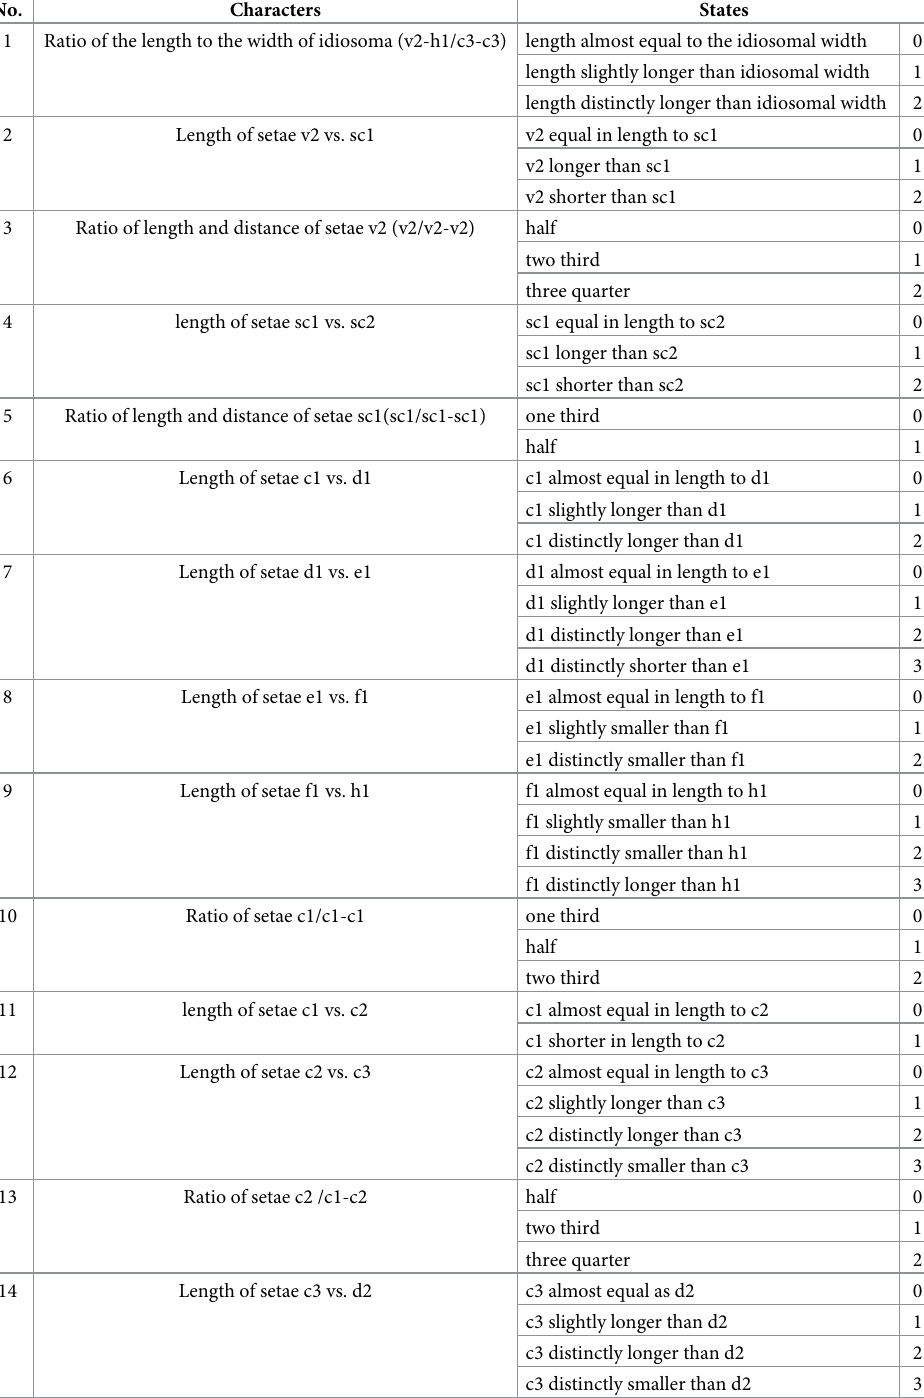
Table 2. Phenotypic characters used in heirachical cluster analysis of E . orientalis populations collected from dif- ferent hosts and regions in Saudi Arabia. No. Characters States Ratio of the length to the width of idiosoma (v2-h1/c3-c3) length almost equal to the idiosomal width 0 length slightly longer than idiosomal